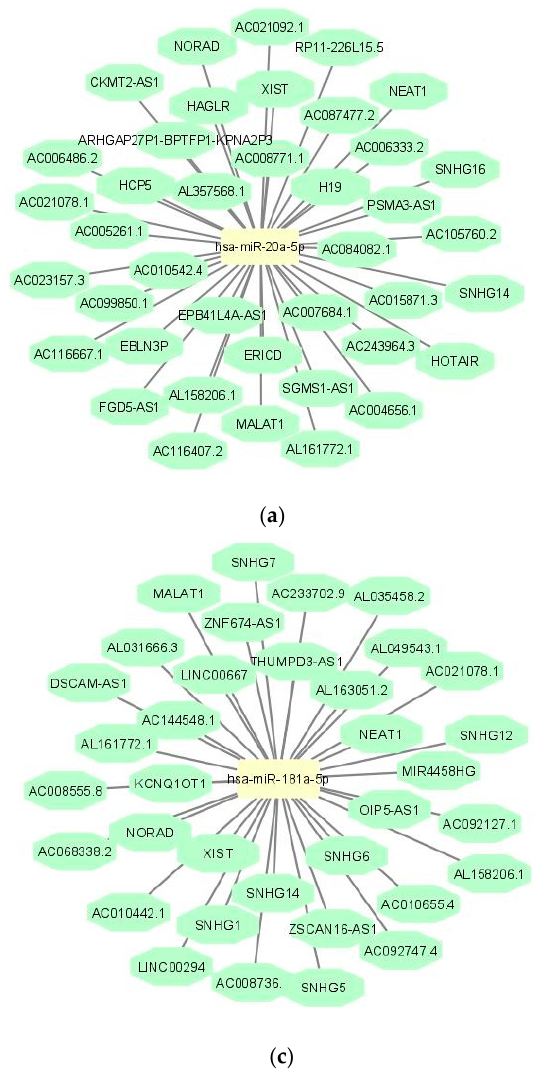
Figure 1. In silico analysis of the lncRNAs targeting hsa-miR-20a-5p and hsa-miR-181a-5p. ( a ) lncRNAs that target hsa-miR-20a-5p according to StarBase database analysis; ( b ) details about the binding site of hsa-miR-20a-5p on SNHG16, predicted by StarBase database; ( c ) lncRNAs that target hsa-miR-181a-5p according to StarBase database analysis; ( d ) details about the binding site of hsa-miR-181a-5p on SNHG6, predicted by StarBase database.